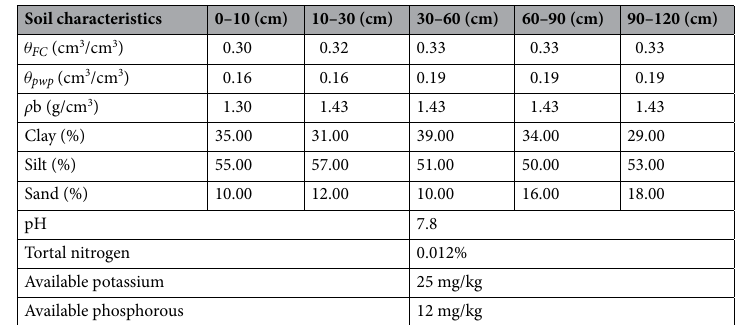
Table 1. Characteristics of soil in different depths (cm) in the field in pea experiment. ρb, bulk